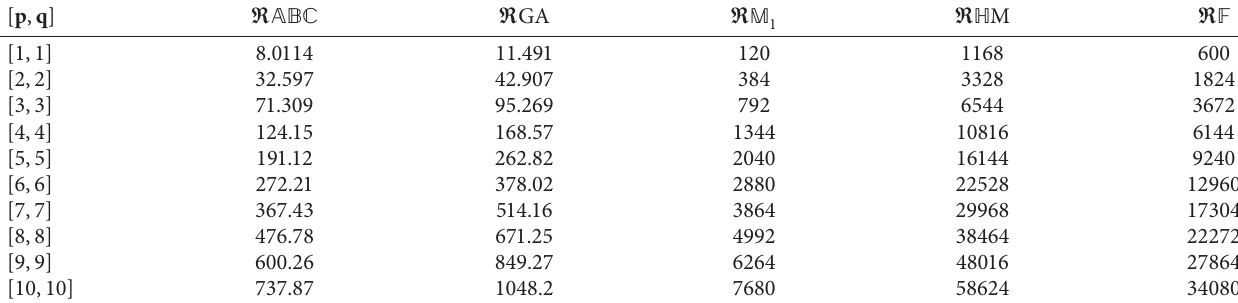
, R H M, and R F for Case 1. 1